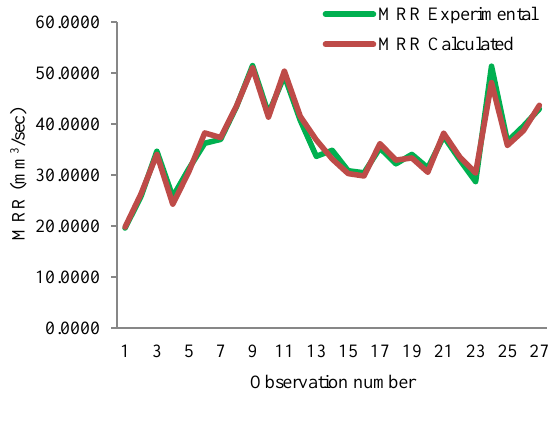
Fig. 8. Validation of Model for MRR Fig. 9. Validation of Model for Power Required for